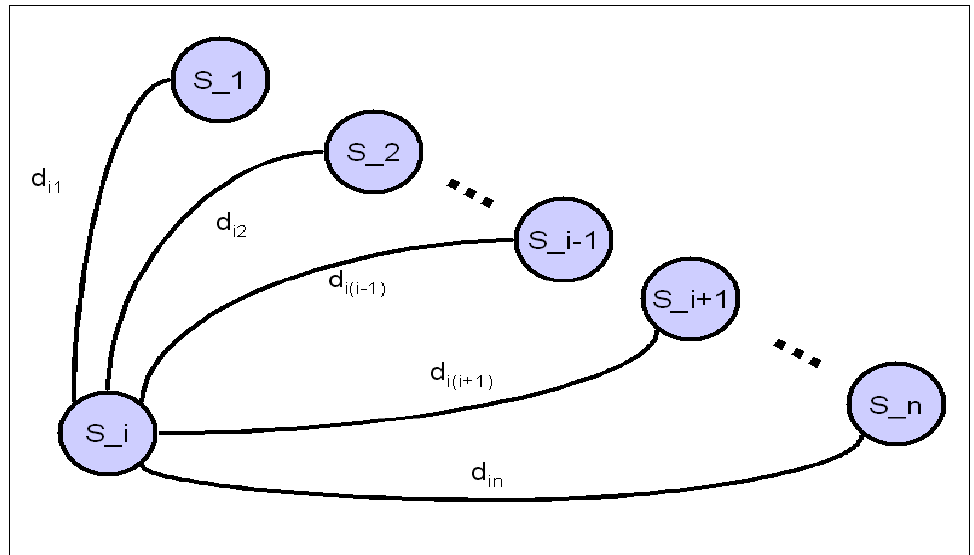
Figure 4. Distances from S_i to each sensor on the